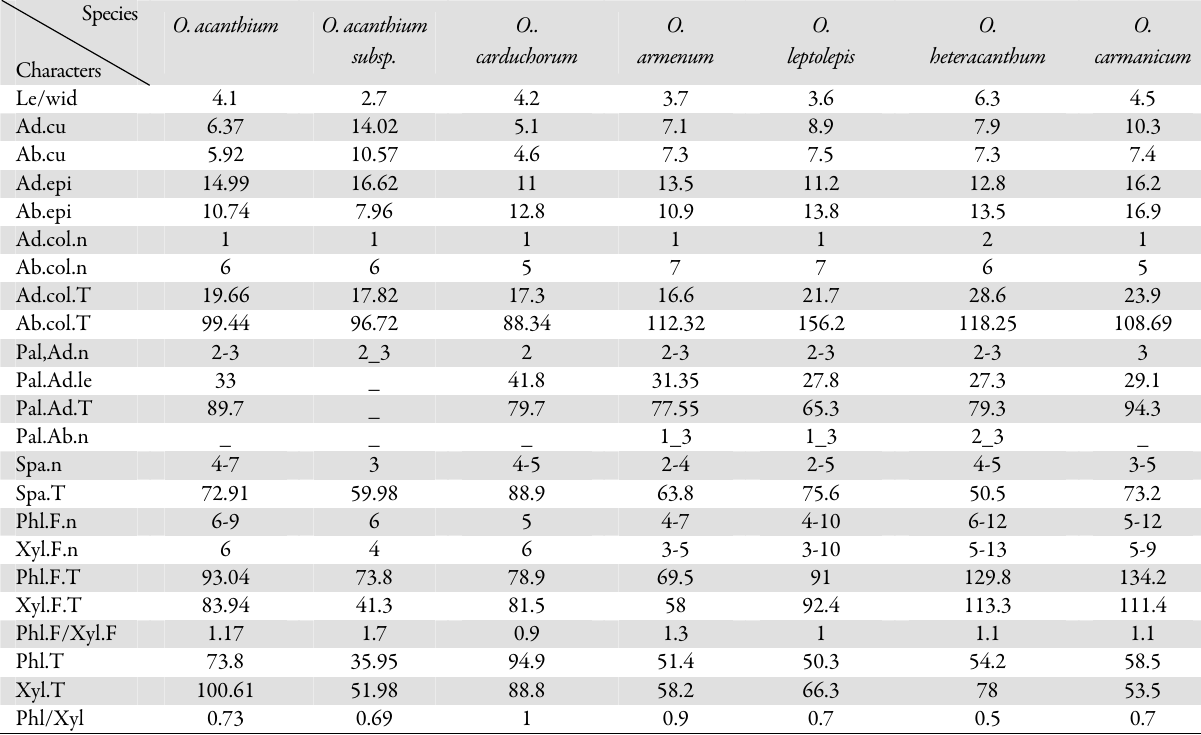
Tab. 3. Anatomical quantitative characters of leaf in studied species (The unit is µm).Le/Wid: Length of stem section/Width of stem section, Ad. Cu: Adaxial Cuticle's Thickness, Ab. Cu: Abaxial Cuticle's Thickness, Ad. Epi: Adaxial Epidermis Length, Ab. Epi: Abaxial Epidermis Length,